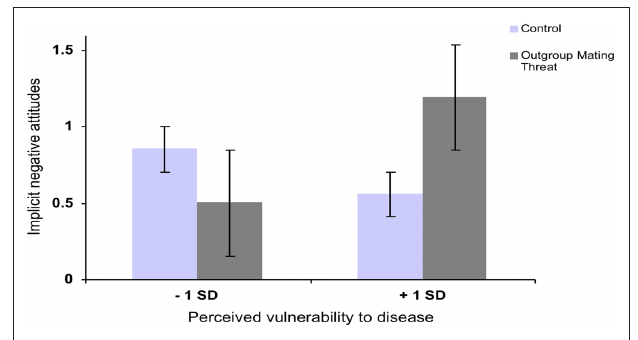
Figure 1 | implicit negative attitudes as a function of experimentally manipulated out-group mating threat and dispositional perceived vulnerability to disease among men (error bars indicate standard